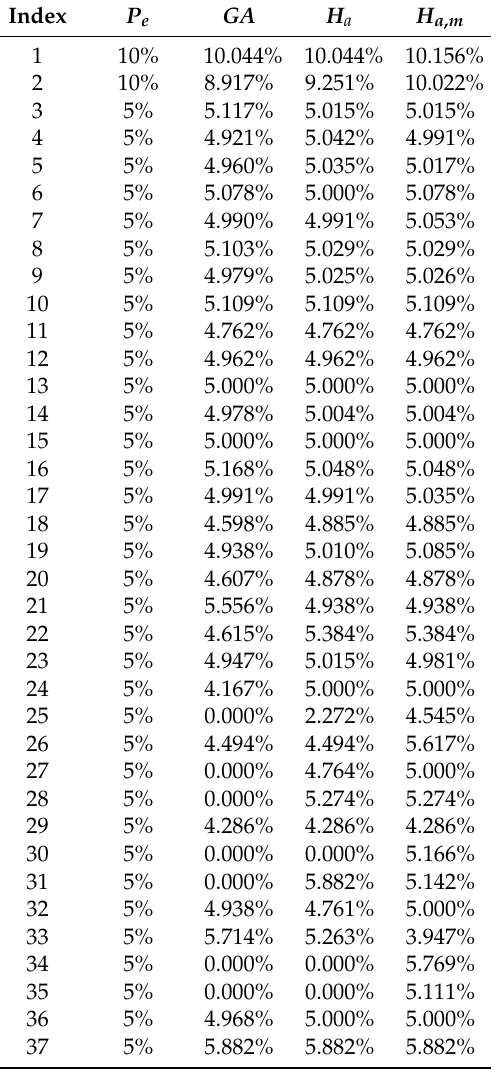
Table 2. Sampling results under each algorithm.